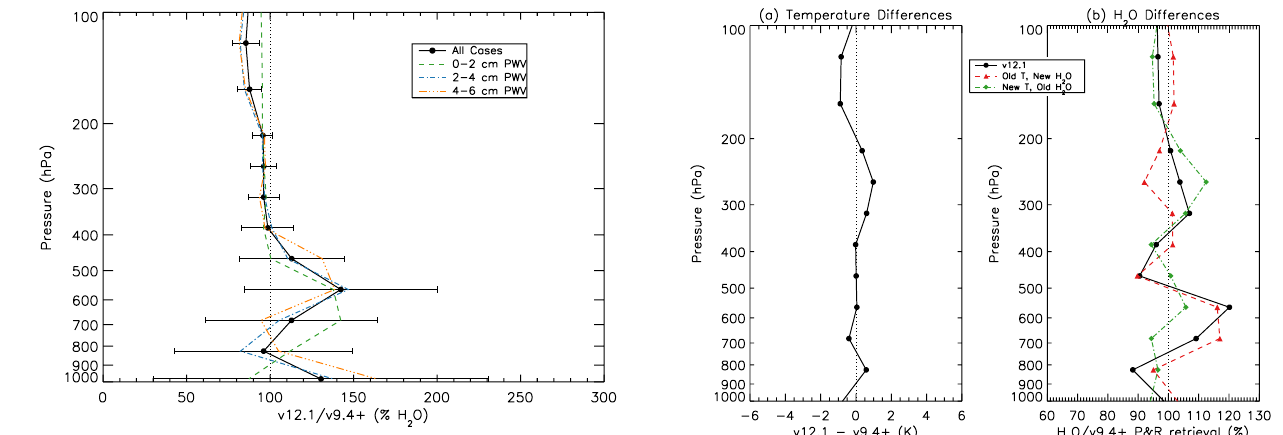
Fig. 23. Same as Fig. 18 but for an example spectrum with 0.3cm